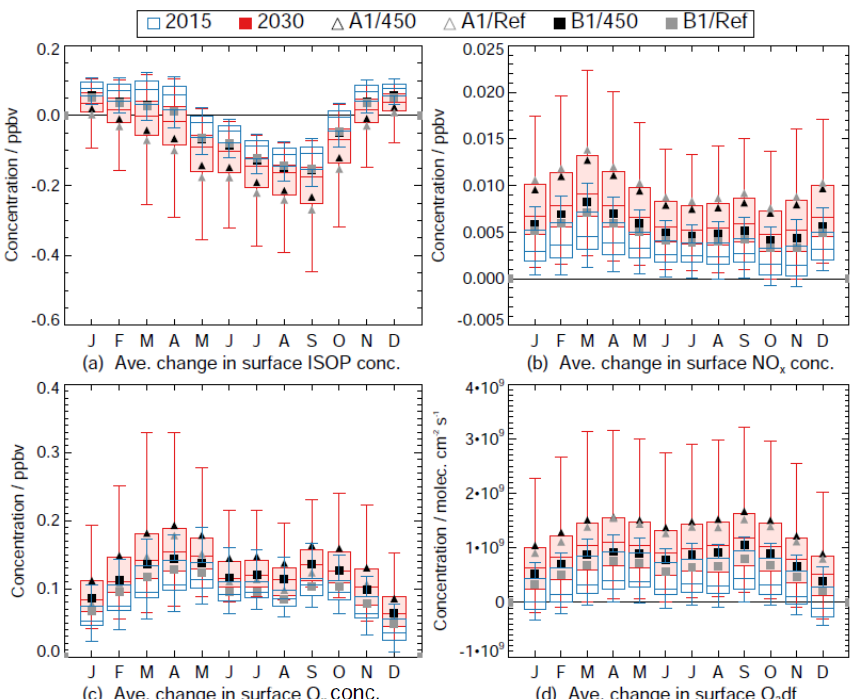
Fig. 7. Monthly mean statistics, expressed using box and whisker plots, for the change in isoprene (ppb), NO x (ppb), and O x (ppb) surface concentrations and O 3 dry deposition (moleculescm − 2 s − 1 ) over Africa (Fig. 6) for 2015 and 2030.